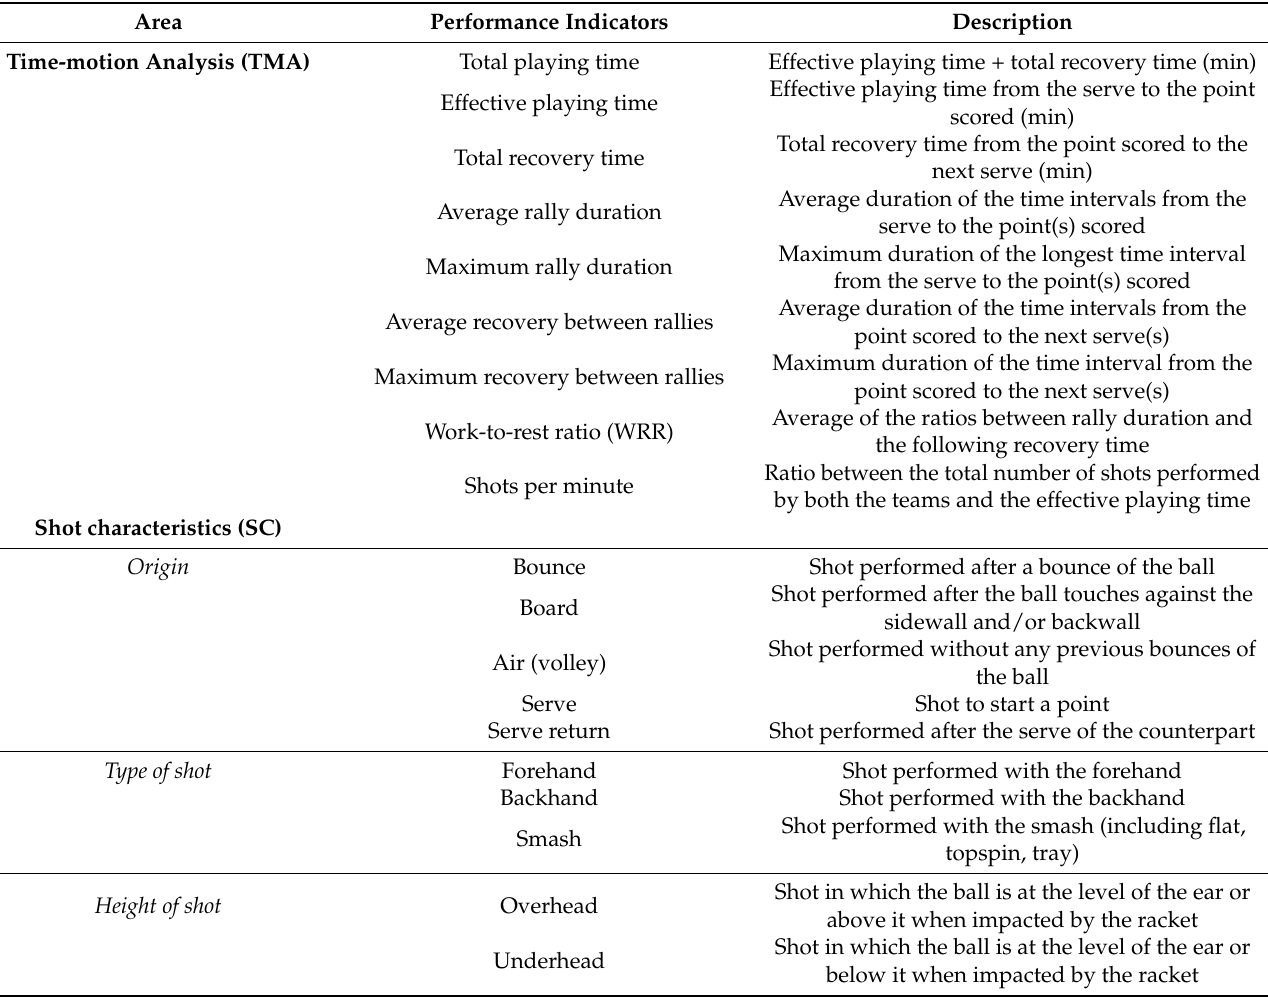
Table 1. Description of the KPIs according to the 5 areas of investigation: time-motion analysis (TMA), shots characteristics (SC), errors (E), serve (S) and points won (PW). Area Performance Indicators Description Time-motion Analysis (TMA) Total playing